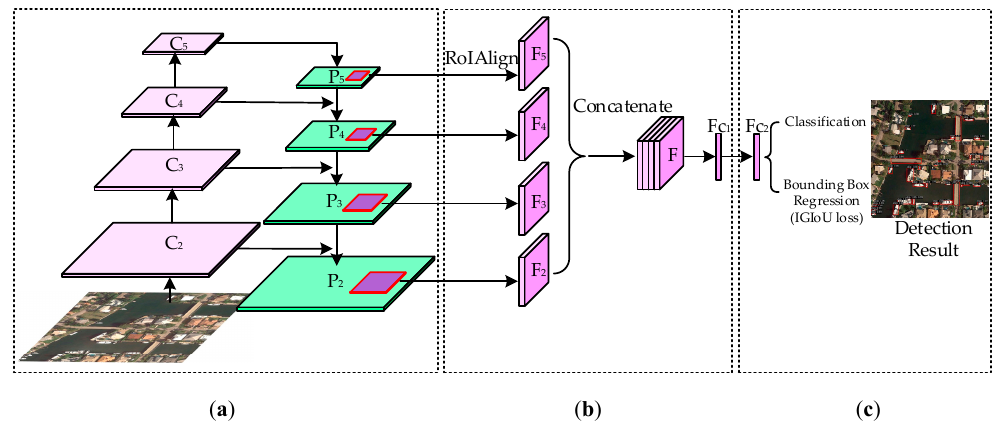
Figure 1. Framework of our object detection in remote sensing images (ODRSIs) method. ( a ) feature pyramid network (FPN) backbone; ( b ) Multi-level features fusion; ( c ) Classification and bounding box regression based on IGIoU